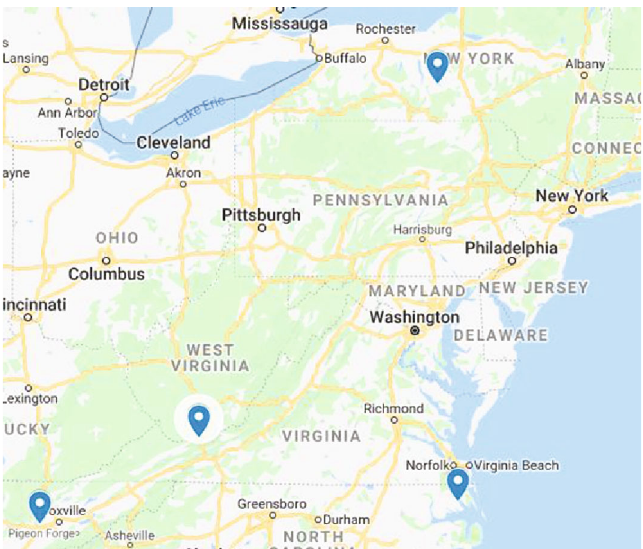
Figure 1: Map of four pyranometer locations for the TGHI dataset, bottom left; NCGHI dataset, bottom right; WVGHI dataset, bottom center; and NYI dataset, top (Google map).